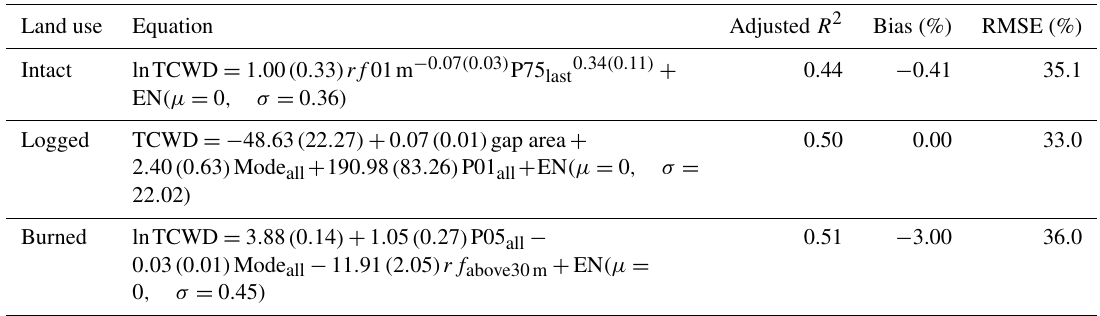
Figure 3. Measured values of total CDW (TCDW) versus values predicted by the models for lidar-only scenarios for forests classified as (a) intact (adjusted R 2 : 0.44; RMSE (%): 35.1), (b) logged (adjusted R 2 : 0.50; RMSE (%): 33.0), and (c) burned (adjusted R 2 : 0.51; RMSE (%): 36.0). Table 4. Equations, adjusted R 2 , mean relative bias (%), and relative root mean square error (RMSE in %) of the lidar-only scenario for predicting CDW in intact and degraded forests using lidar variables. rf 01m is return fractions between 0 and 1m height of the last returns ; P75 last is the 75th percentile of last returns in meters; gap area is gap area in m 2 ha − 1 ; Mode all is mode of all returns in meters. P05 all is the fifth percentile of all returns in meters; rf above30m is return fraction above 30m of all returns. EN is residual following a normal distribution with µ and σ